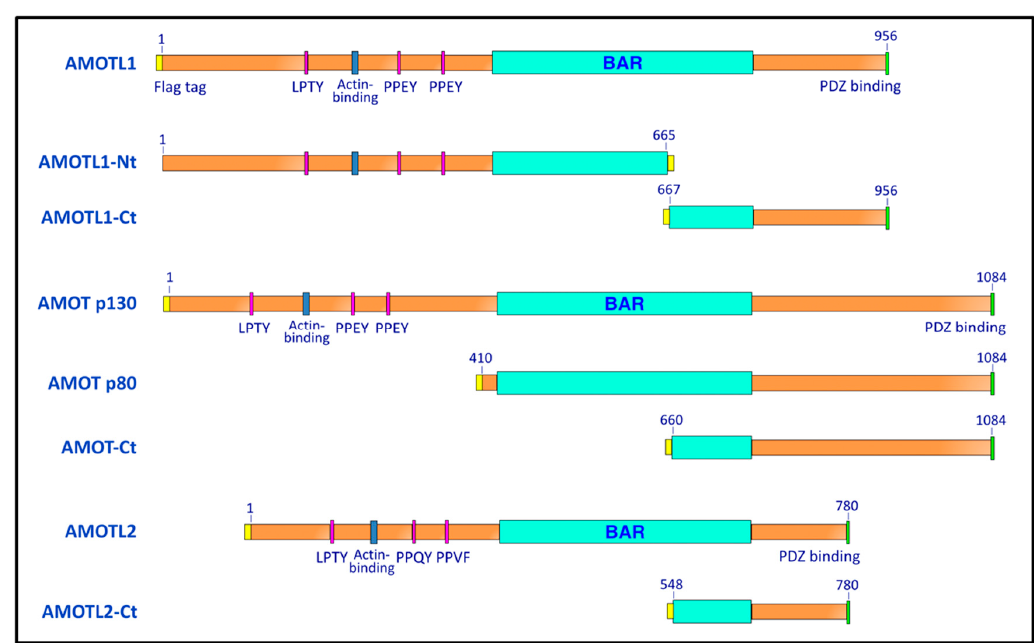
Figure 1. Schematic illustration of the angiomotins and angiomotin-derived polypeptides. Numbers indicate the span of amino acid residues that are contained within each construct. All constructs are Flag-tagged, with the positions of the tags indicated by the yellow regions. AMOT p80 is a naturally-occurring splice variant of AMOT that lacks the entire PPXY-containing N-terminal region, but retains the consensus BAR and PDZ-binding domains.